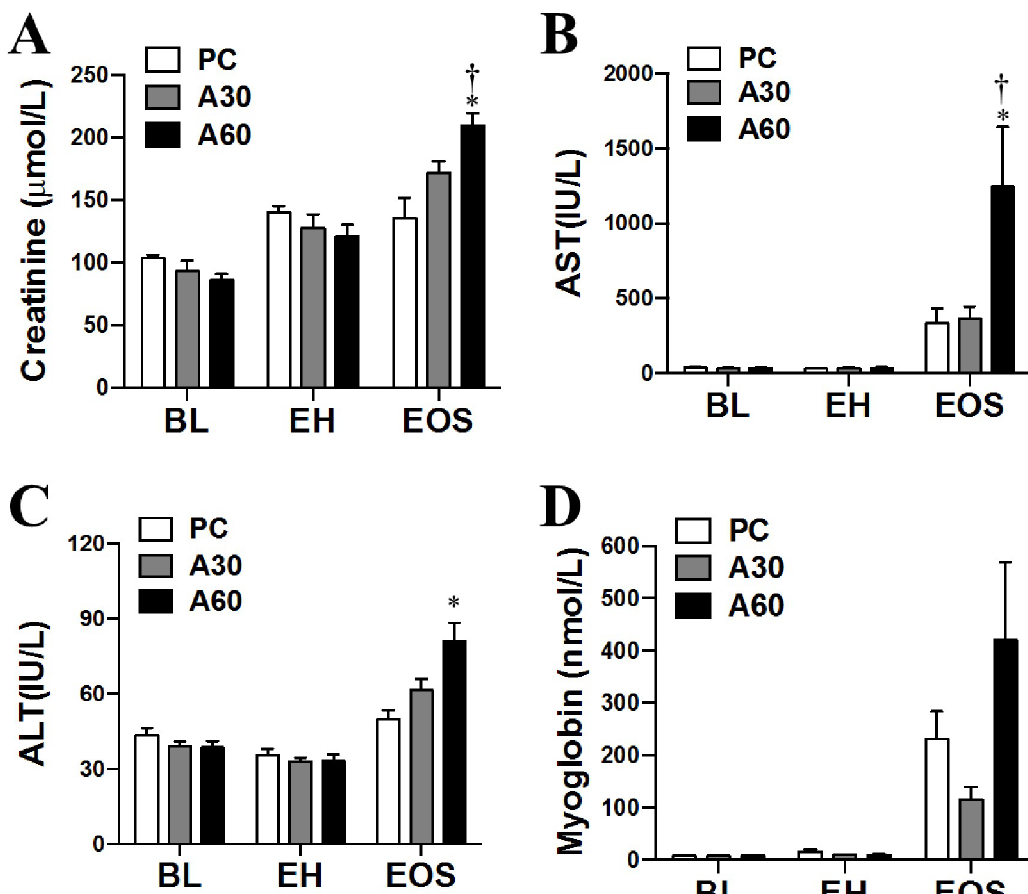
Fig 6. Changes of end-organ damage in plasma from swine undergoing cREBOA. Data are presented as mean ± SEM and were statistically analyzed using two-tailed Mann-Whitney test. � p < 0.05, PC vs . A60 group; † p < 0.05, A60 vs . A30 group. ALT, alanine aminotransferase; AST, aspartate